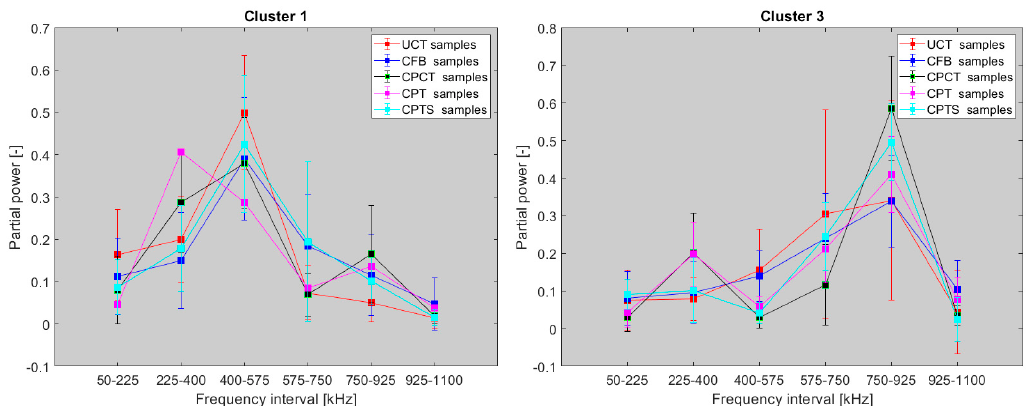
Figure 12. Mean values of the partial power variable corresponding to individual frequency intervals (Fujicera 1045S dataset, clusters one and three).